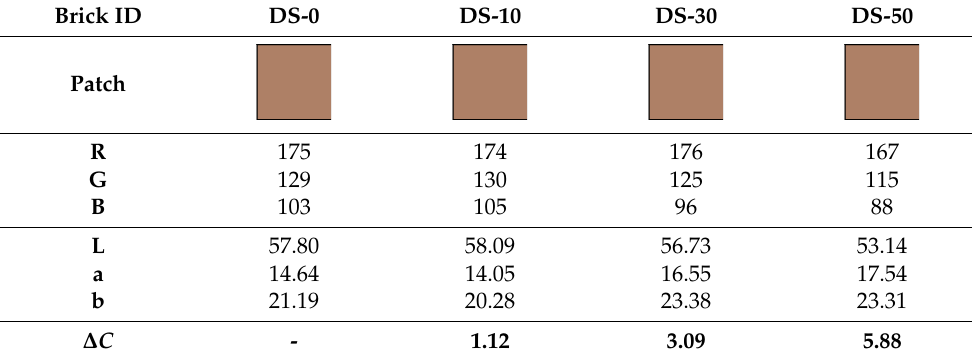
Table 7. RGB and CIE Lab color space coordinates associated to the bricks’ color patterns, and color shift values from the reference case (DS-0).